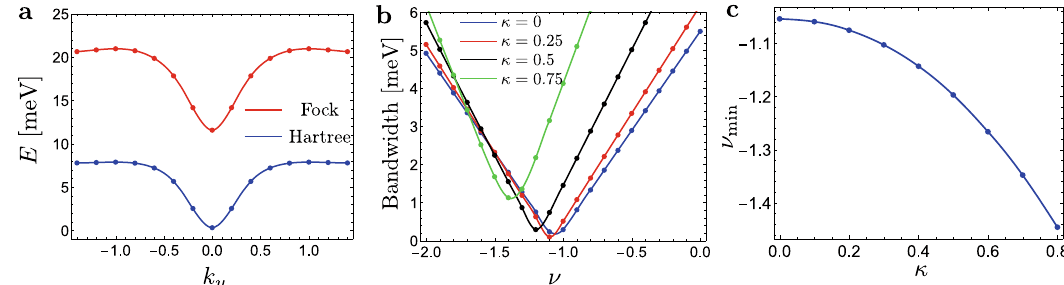
Fig. 4 | Details of the approximate Hartree – Fock dispersion. a Hartree ϵ H ( k ) and Fock ϵ F ( k ) dispersion. b Bandwidth for the dispersion ϵ ν ( k ) as a function of ν for different values of κ . c Value of ν for which the bandwidth is minimum as a function of κ